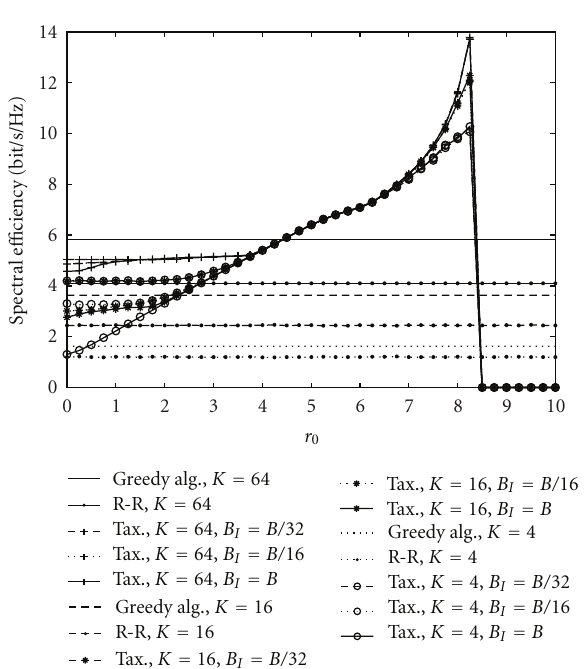
Figure 3: Spectral e ffi ciency η SE versus the tax rate for SelBM; two- path channel model.